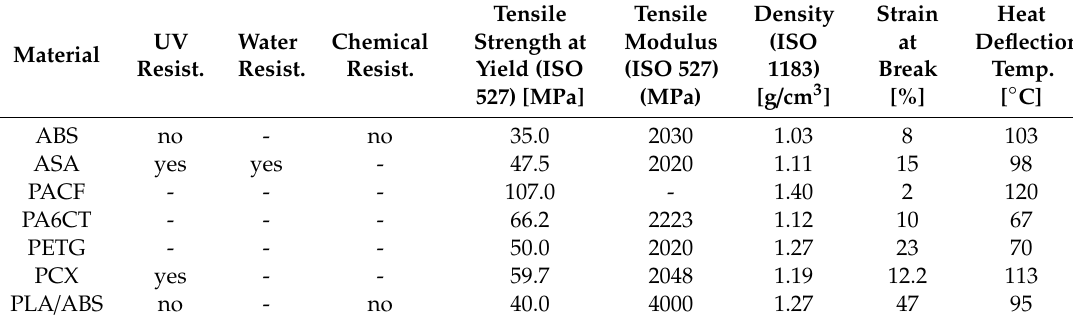
Table 4. Material characteristics (manufacturer specifications).